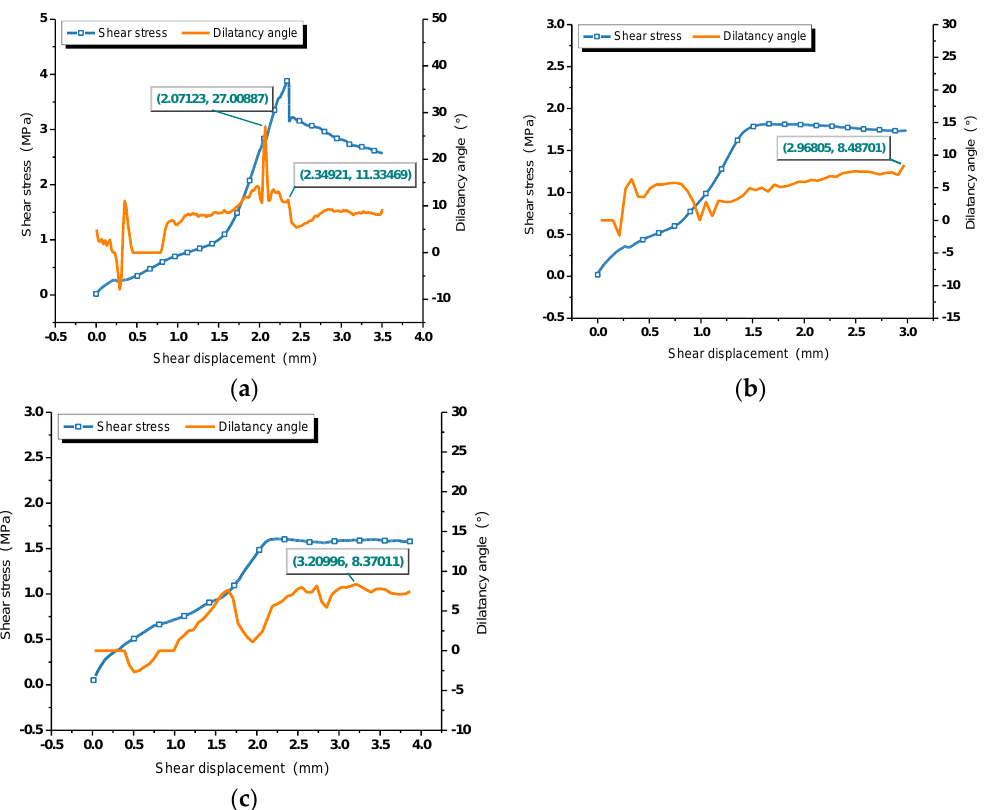
Figure 10. The relationship between shear displacement, dilatancy angle, and shear stress. ( a ) First shearing; ( b ) Second shearing; ( c ) Third shearing. As can be observed in Figure 11, d n of the first shearing ranges between 15° and 50°, d n of the second shear is distributed in the intervel from 5° to 15°, and d n of the third shear changes from 0° to 10°. With the increase of shear times, the peak dilatancy angle decreases, and the interface with larger normal stress has a greater reduction of peak dilatancy angle. Meanwhile, the differences between the peak dilatancy angles of each interface are getting smaller, indicating that its sensitivity to the normal stress, the interface material, and the roughness is decreasing. However, by comparing the peak dilatancy angle of the first shearing, it can be found that the dilatancy angle corresponding to malmstone is generally larger, followed by red sandstone and blue sandstone.